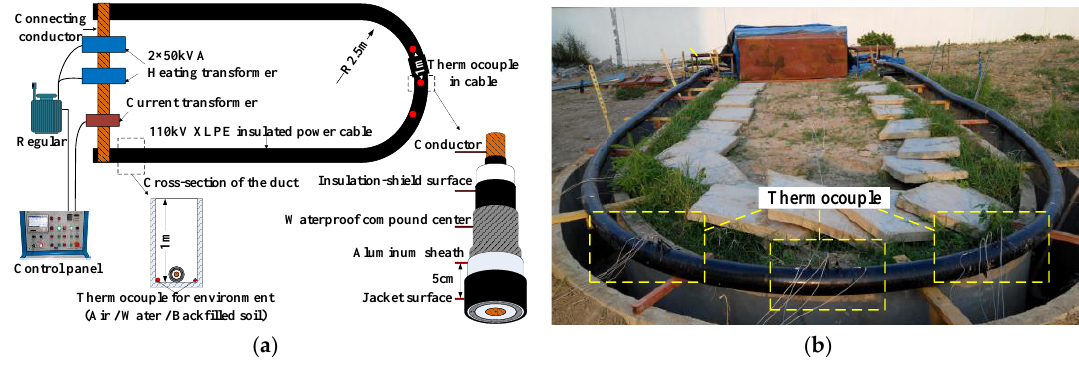
Figure 6. Experimental arrangement: ( a ) diagram and ( b ) actual scene.